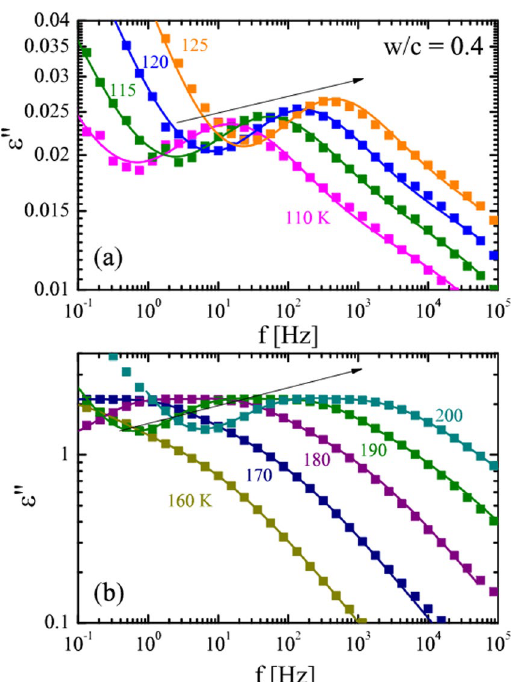
Figure 2. ( a and b ). Imaginary part ( ε″ ) of the dielectric spectra of Portland cement after three weeks of preparation with w / c = 0.4 at different temperatures (see plot). The solid lines through the data points represent the fits to the experimental